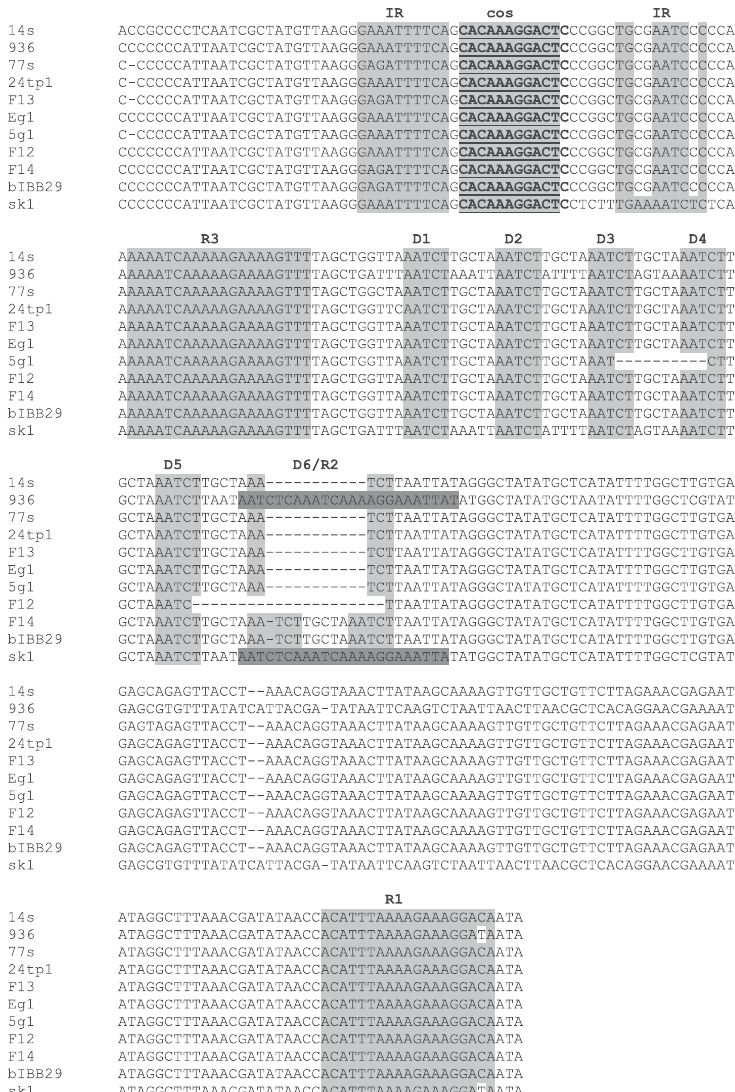
Figure 6. Comparative sequence analysis of aligned cos regions of Lactococcus phages sequenced in this study using the ClustalOmega tool. Sequences characteristic of phage 936-type cos regions are shaded in grey. Cos sites are underlined. IR: inverted repeats, R1-3: putative terminase binding sites, D1-6: direct